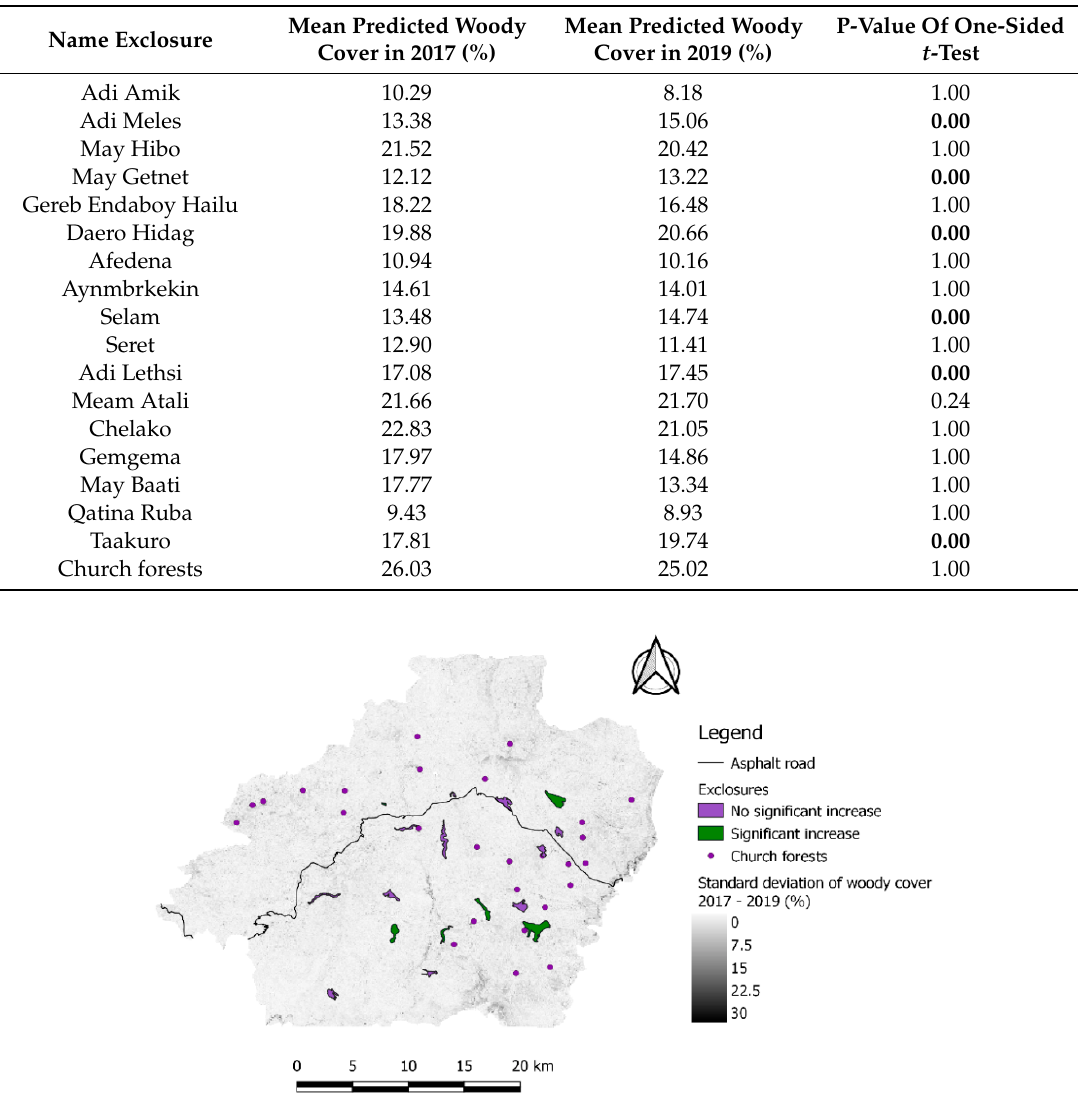
Table A6. The mean predicted woody cover values for each exclosure and the church forests for 2017 and 2019, together with the p-values of the one-sided t -test. All 25 church forests were merged for the t -test calculation for simplicity. The p-values smaller than 0.05 are shown in bold.